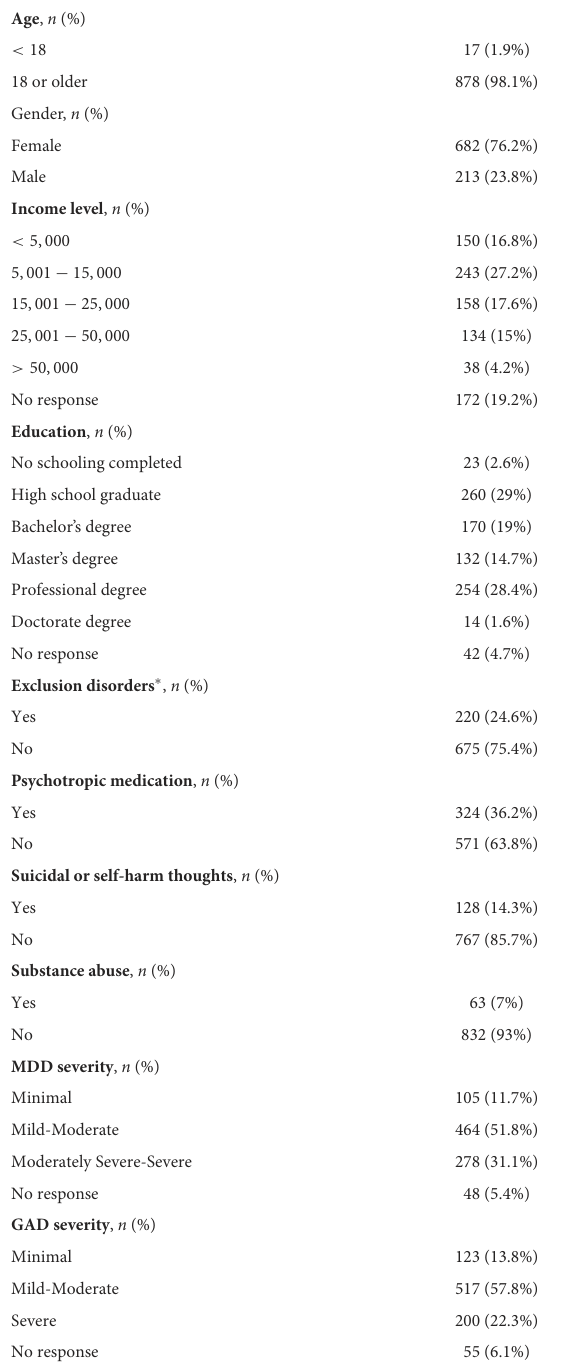
TABLE 1 Candidate responses to the demographic and eligibility